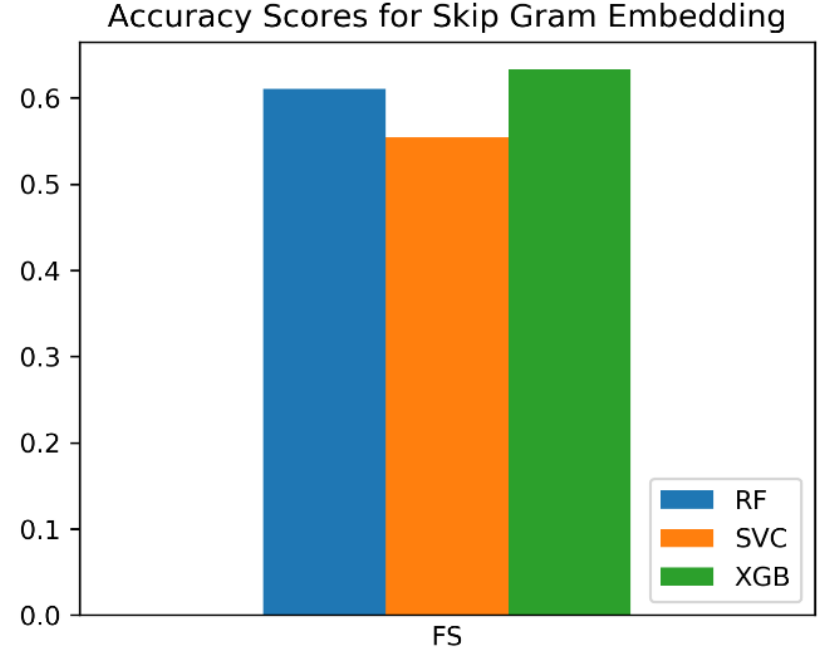
Figure 10. F 1 scores of self-trained Word2Vec embedding with the Skipgram